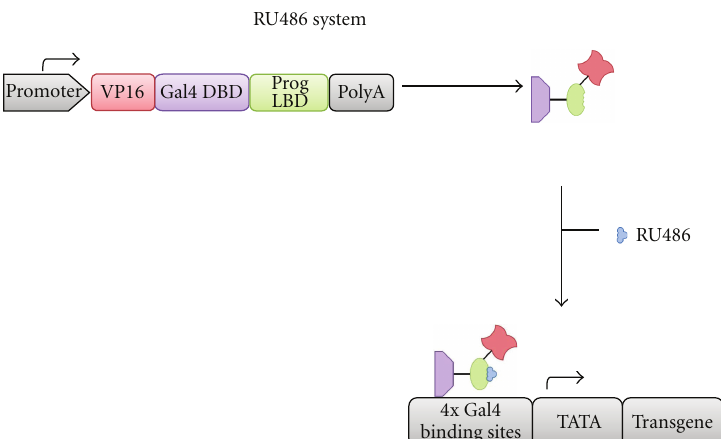
Figure 4: Schematic of the RU486 regulation system. A constitutively active promoter drives expression of a fusion protein consisting of a VP16 activation domain, a Gal4 DNA-binding domain (DBD) and a progesterone ligand-binding domain (Prog LBD). Binding of RU486 to the Prog LBD enables dimerization and binding to 4x Gal 4-binding sites upstream of a TATA box driving transgene expression [28]. Poly A, poly adenylation